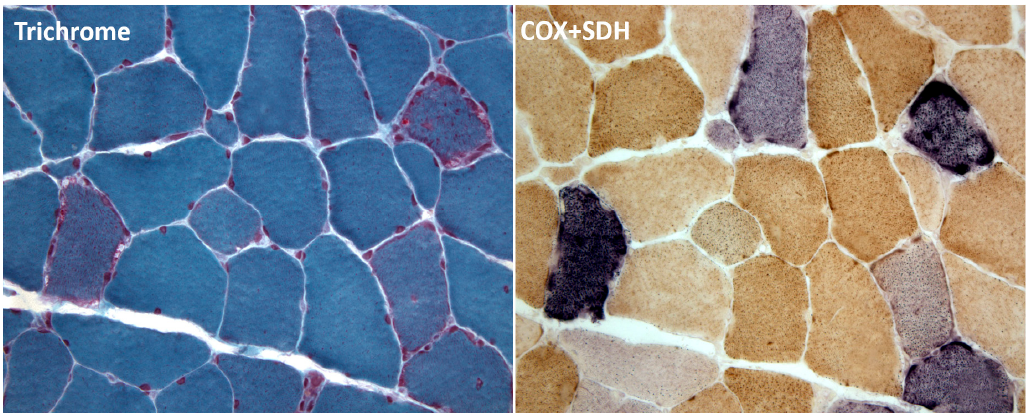
Figure 2. Cytochrome c oxidase (COX) / succinate dehydrogenase (SDH) overlap staining in a muscle biopsy. This patient with myoclonic epilepsy and ragged-red fibers (MERRF) shows typical “ragged red fibers” (RRF) by trichrome at left. However, COX / SDH overlap staining (at right) shows COX-negative, “ragged-blue” fibers, mixed with COX-deficient bluish fibers.